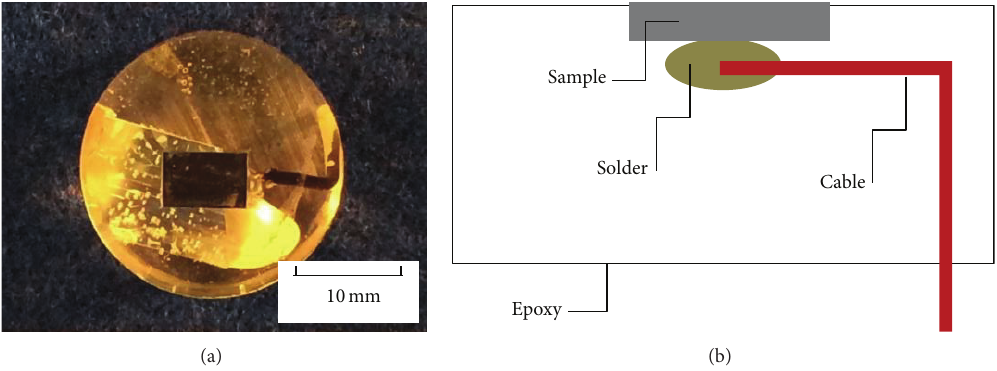
Figure 1: (a) Pitting testing specimen and (b) schema of specimen (electric conduction).